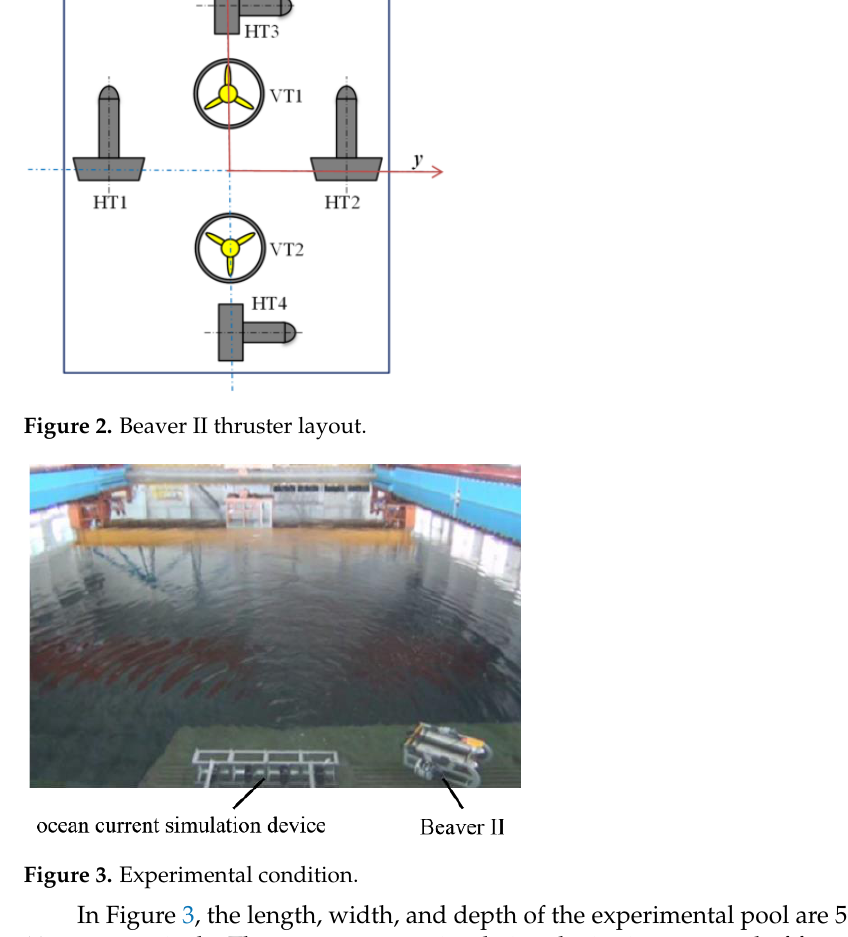
Figure 2. Beaver II thruster layout.